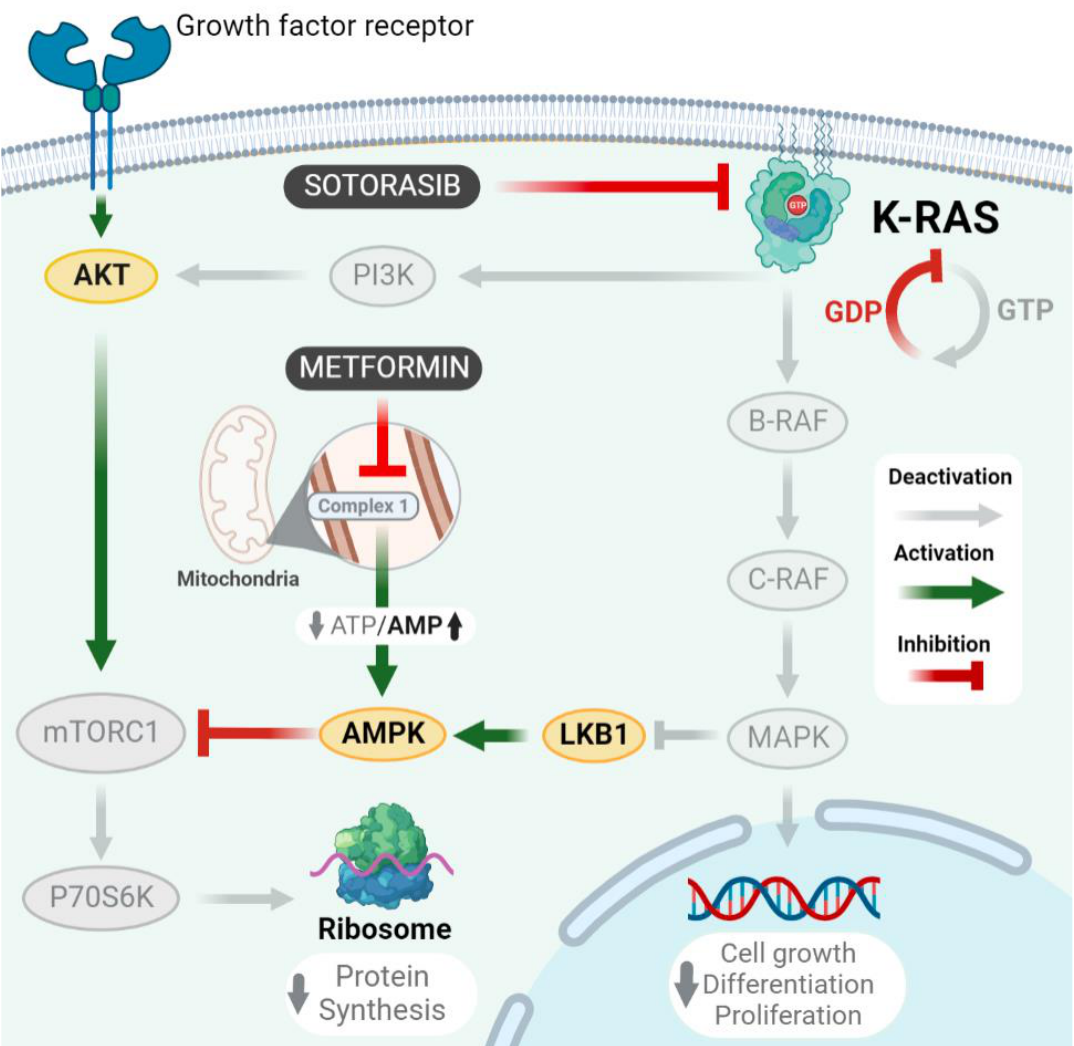
Figure 5. Possible action mechanism of metformin and sotorasib as combined treatment. Lung cancer cells enhance their proliferation and metastatic potential through mutations in growth factor receptors and KRAS. In detail, KRAS interacts with PI3K-AKT-mTORC1 pathway, and inhibits LKB1, then allowing mTOR-driven activation of P70S6K, which subsequently increases protein synthesis. As well, KRAS promotes the constitutive activation of MAPK pathway, enhancing cell growth and proliferation. In this context, our combined treatment simultaneously inhibits MAPK signaling by sotorasib, and P70S6K by metformin.